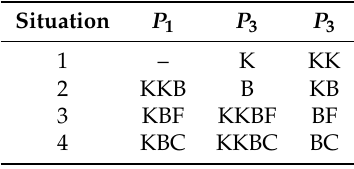
Table 2. Betting situations in three-player Kuhn poker. For each player and situation, the sequence of capital letters denotes the history of the betting so far. ‘K’ stands for the action of “check” (which passes the turn to the next agent and does not put additional money in the pot); ‘F’ stands for “Fold” (give up on the hand and forfeit the pot); and ‘B’ stands for “Bet” (put additional money in the pot, which opponents are forced to match to remain in the hand). For example, for row P 1 Situation 1, the history of actions so far is that Player 1 has checked, Player 2 has checked and Player 3 has bet, and it is now Player 1’s